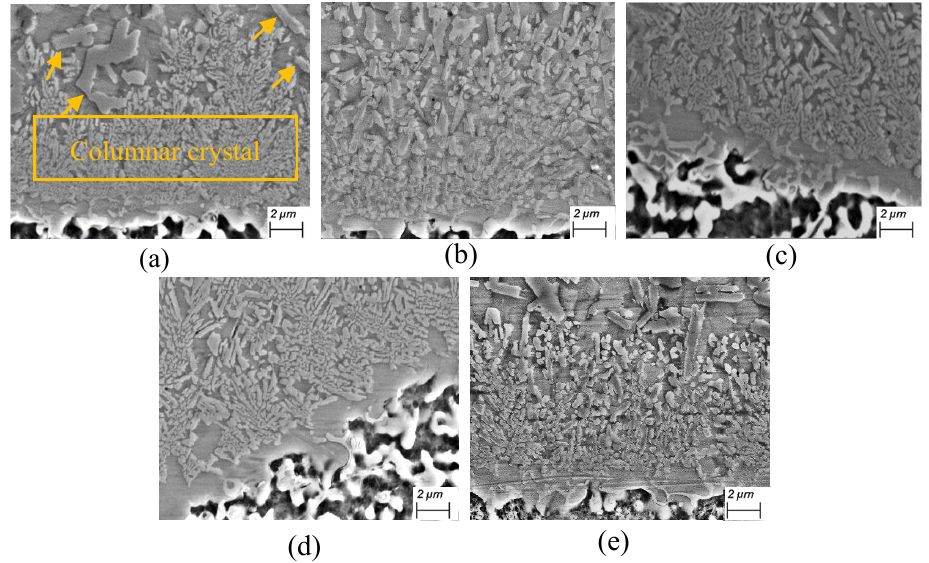
Figure 5. SEM pictures of bottom layer (Ni60) under different ultrasonic frequencies. ( a ) 0; ( b ) 26 kHz; ( c ) 30 kHz; ( d ) 34 kHz; ( e ) 38 kHz.